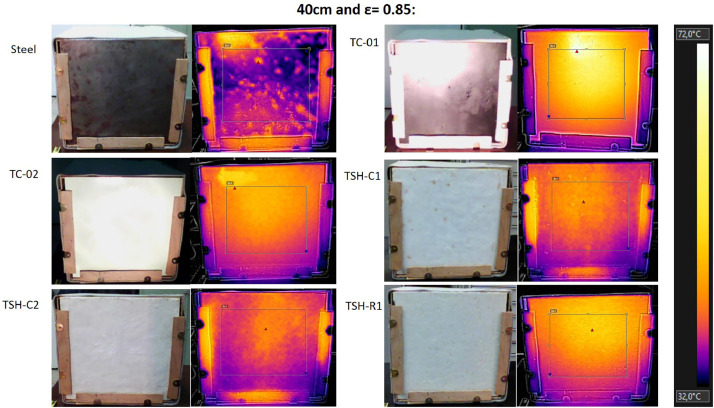
40 cm/no airflow.